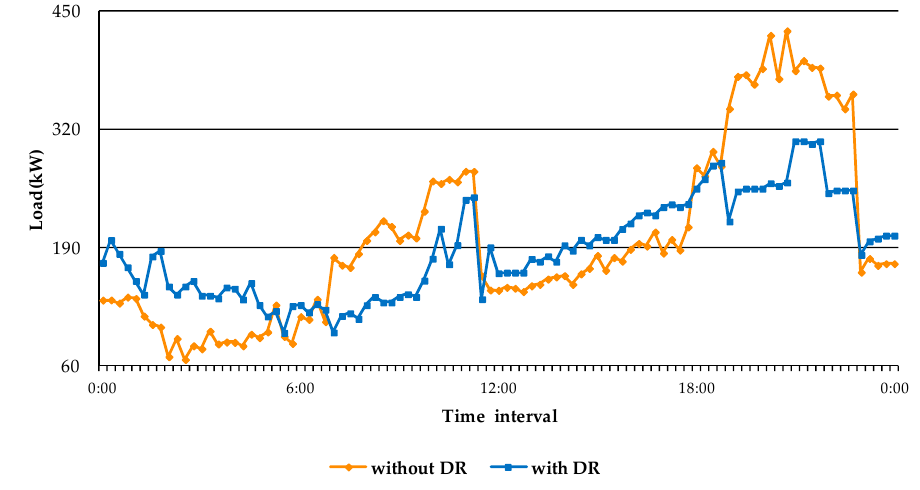
Figure 3. Comparisons between the loads in the VPP for situations with and without DR.